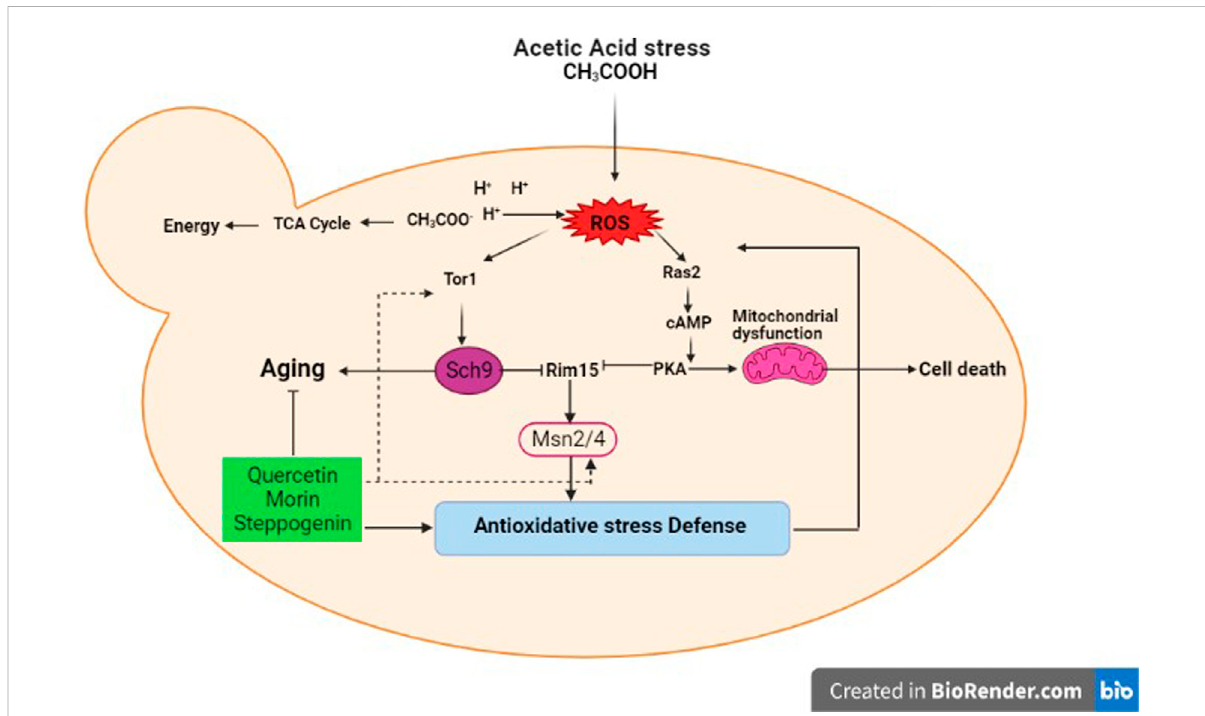
FIGURE 6 Effect of quercetin, morin and steppogenin treatment in mediating ageing intervention in the model yeast S. cerevisiae is proposed. Possible cross-talks between different cellular pathways during the acetic acid stress response under the control of key transcription factors and modulatory signaling kinase of Tor1-dependent pathway are